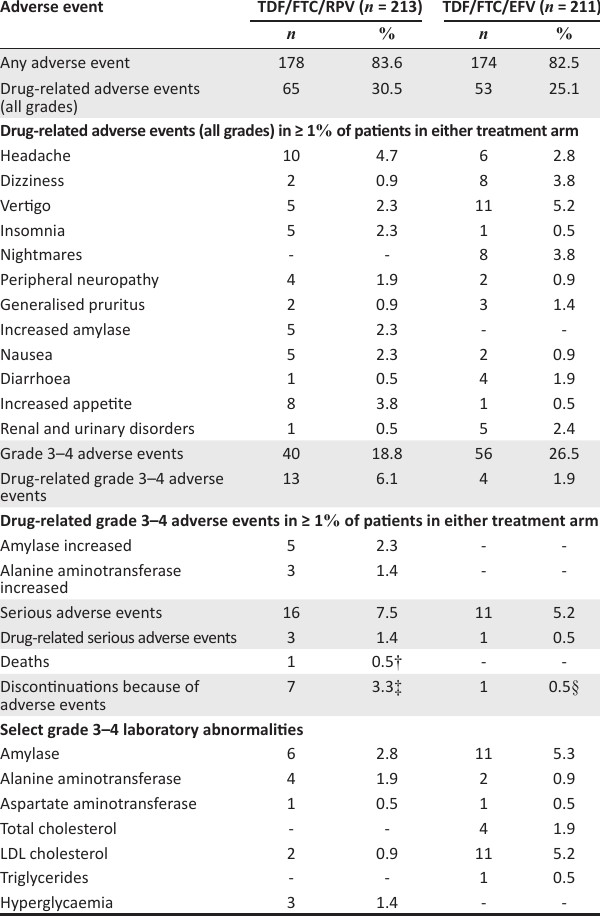
TABLE 3: Clinical adverse events and laboratory abnormalities.